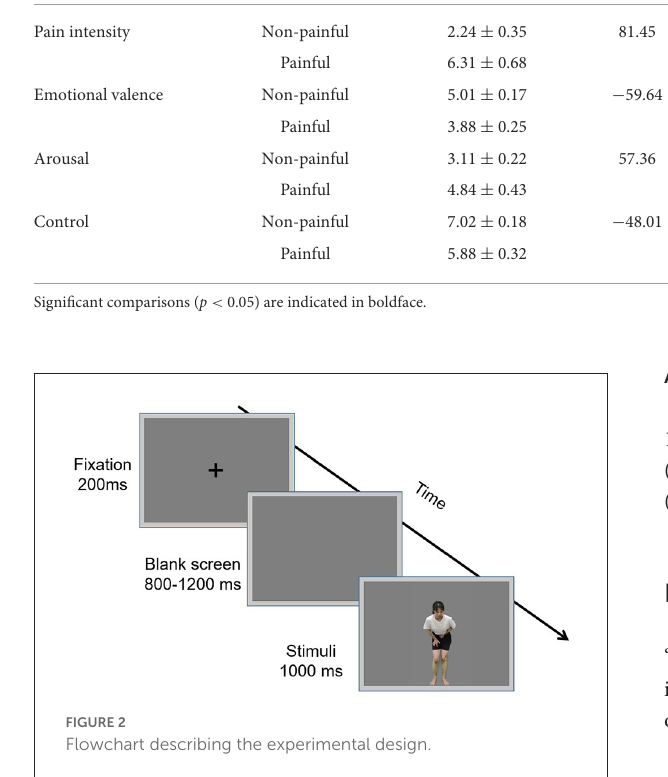
Figure 4. Results of the statistical analyses of the ERP amplitudes are summarized in Table